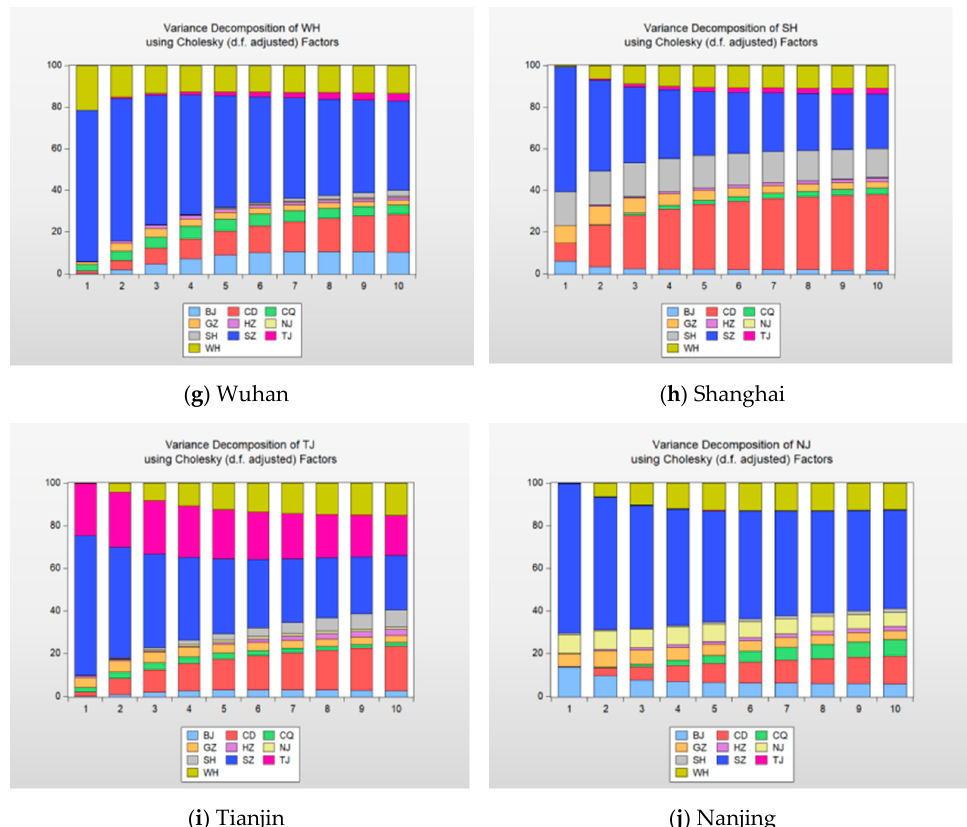
Figure 5. The variance decomposition chart of information attention index in each city.